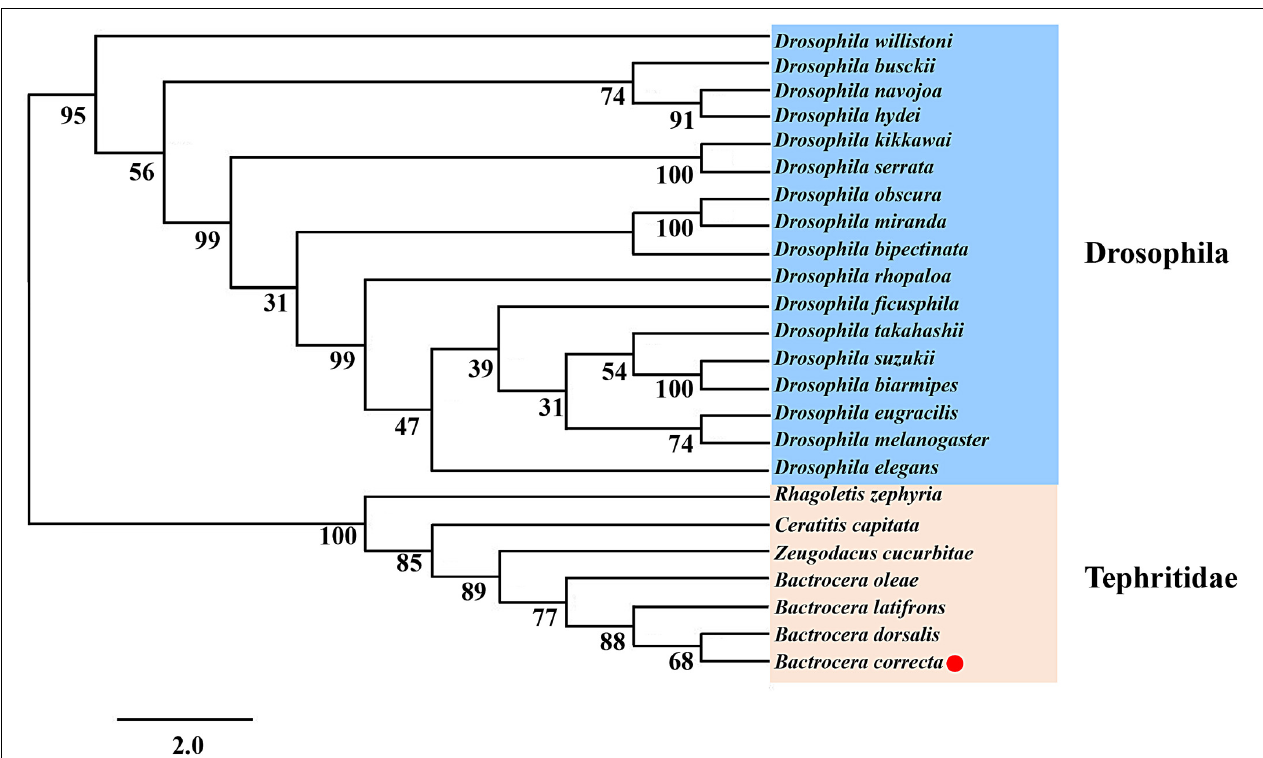
FIGURE 2 | Phylogenetic analysis of Idgf6 using the maximum-likelihood method in RAxML. One hundred bootstrap iterations were conducted to obtain branch support values. The B. correcta Idgf6 sequence we obtained is labeled with a red triangle. The amino acid and nucleotide sequences were downloaded from NCBI. The accession numbers of the genes are designated with the corresponding abbreviations and are listed in Supplementary Table S1 .